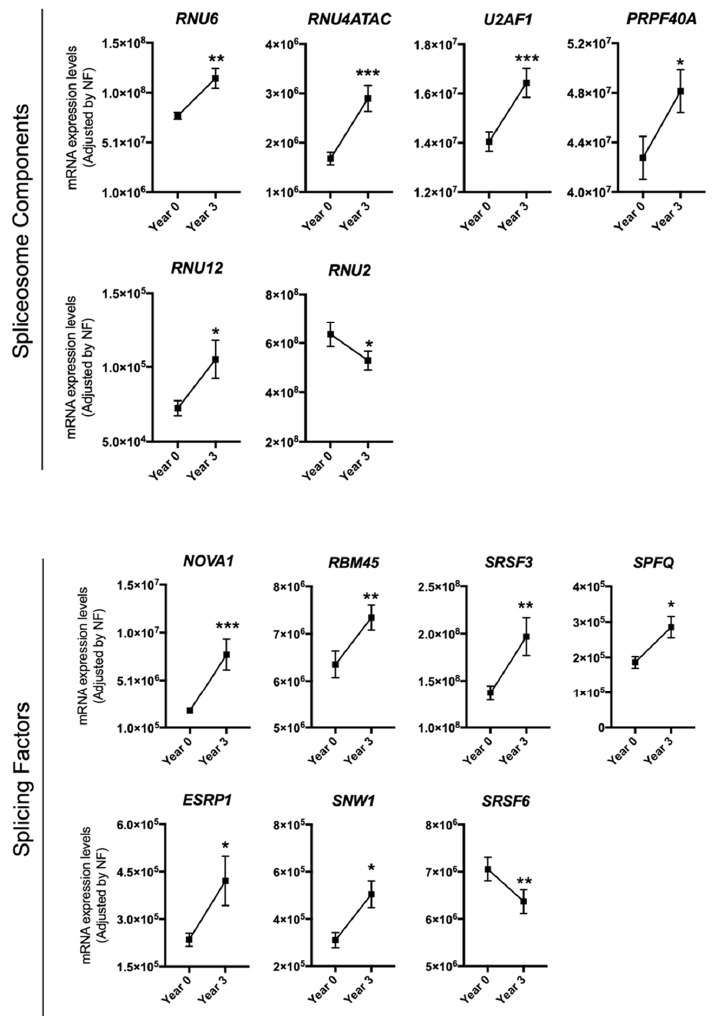
Figure 1. Peripheral blood mononuclear cells (PBMCs) expression pattern of specific splicing machinery components after three years of follow-up. mRNA expression levels (adjusted by a normalization factor (NF) calculated from the expression level of GAPDH and ACTB ) of specific spliceosome components and splicing factors in the PBMCs from all participants included in the study. Values represent the mean ± standard error of the mean (SEM). Asterisks indicate values that significantly di ff er from non-type 2 diabetes mellitus (T2DM) subjects ( t -test: *, p < 0.05; **, p < 0.01; ***, p < 0.001). Table 1. Correlations between the fold change in the expression levels of splicing machinery components (3rd year / baseline levels) and the fold change in relevant T2DM related parameters. Fold Change during Follow-Up Study Population ( n = 215) Incident-T2DM Incident-T2DM + ( n = 107) Non-T2DM Controls SPFQ SRSF6 ρ (rho) − 0.157 HOMA-IR p 0.03 * ρ (rho) − 0.176 Fold change during HIRI follow-up p 0.018 * ρ (rho) 0.227 HbA1c (%) p 0.047